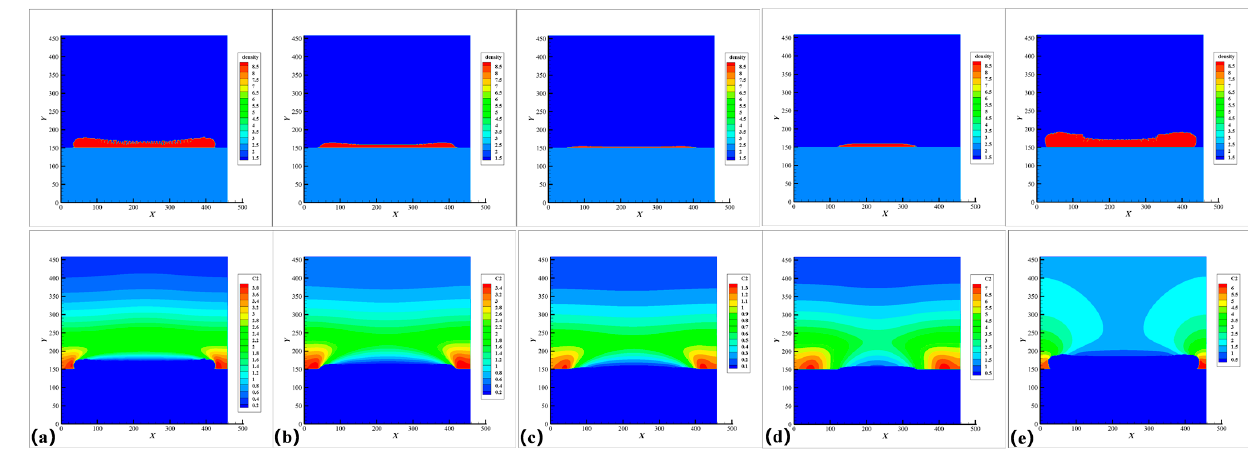
Figure 5. Five typical sediment morphologies and their concentration cloud diagram of C(aq) when the time step is 500,000 steps. upper: morphology, lower: concentration. ( a ) standard condition; ( b ) moderate growth condition; ( c ) low deposition rate condition; ( d ) the condition affected mainly by temperature; ( e ) condition with small roughness. Table 3. Sediment morphologies under different conditions when the time step is 500,000 steps.